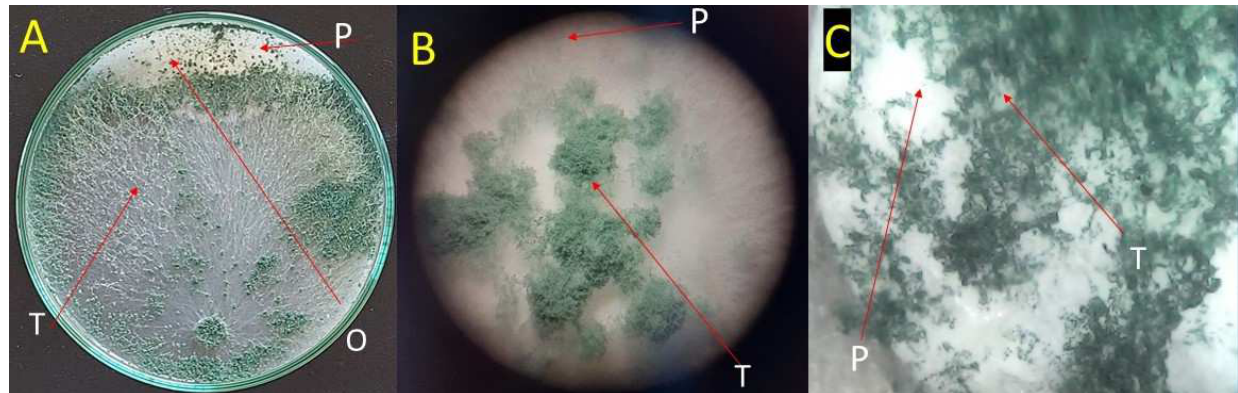
Figure 1. Trichoderma spp. antagonizes (overgrows) the cause of damping-off fungus of pea on PDA plates; ( A ): the two fungi growing on the same PDA plate, showing the overgrowth; ( B , C ): overgrowth view of Trichoderma spp. on the fungal pathogen at 10×, and 100×, respectively. Where T-arrow: Trichoderma spp., P-arrow: fungal pathogen, and O-arrow: overgrowth region.